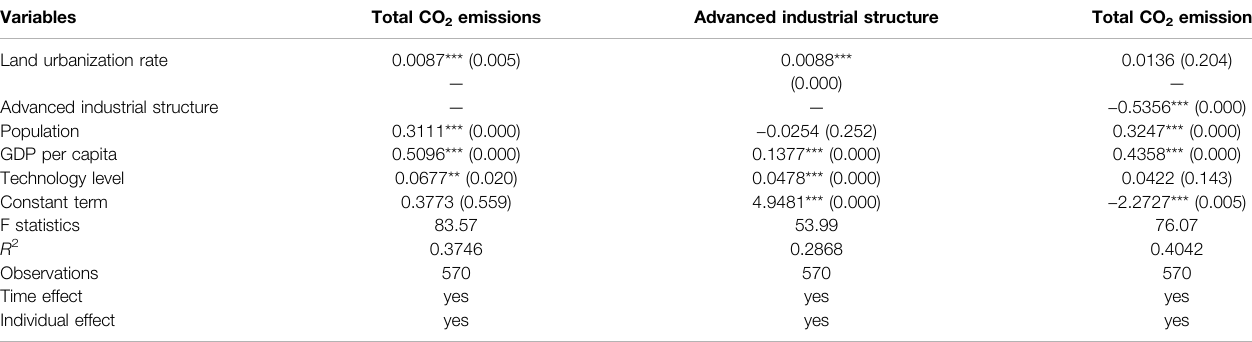
TABLE 5 | The mediating effect of the advanced industrial structure. Variables